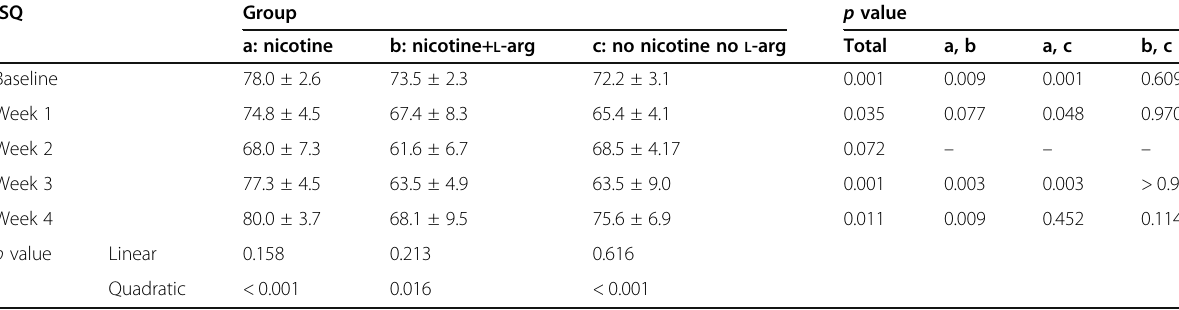
Table 2 Comparison of ISQ between the 3 groups in five different times ISQ